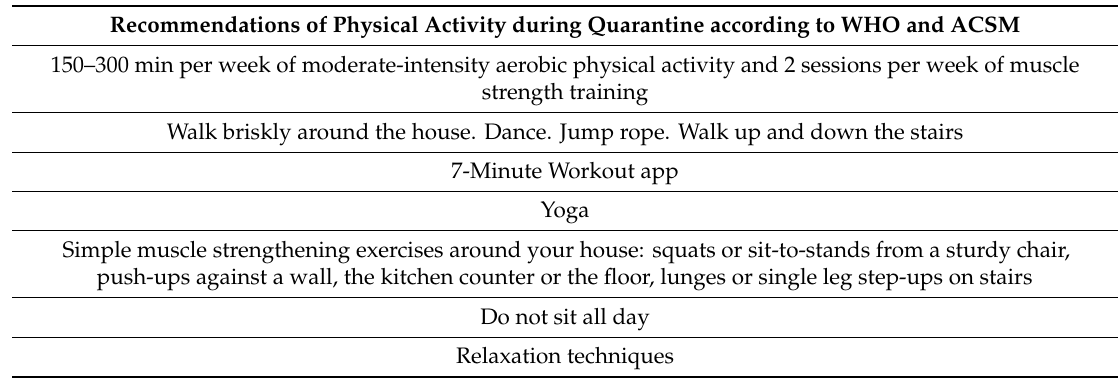
Table 2. Guidelines during quarantine according to